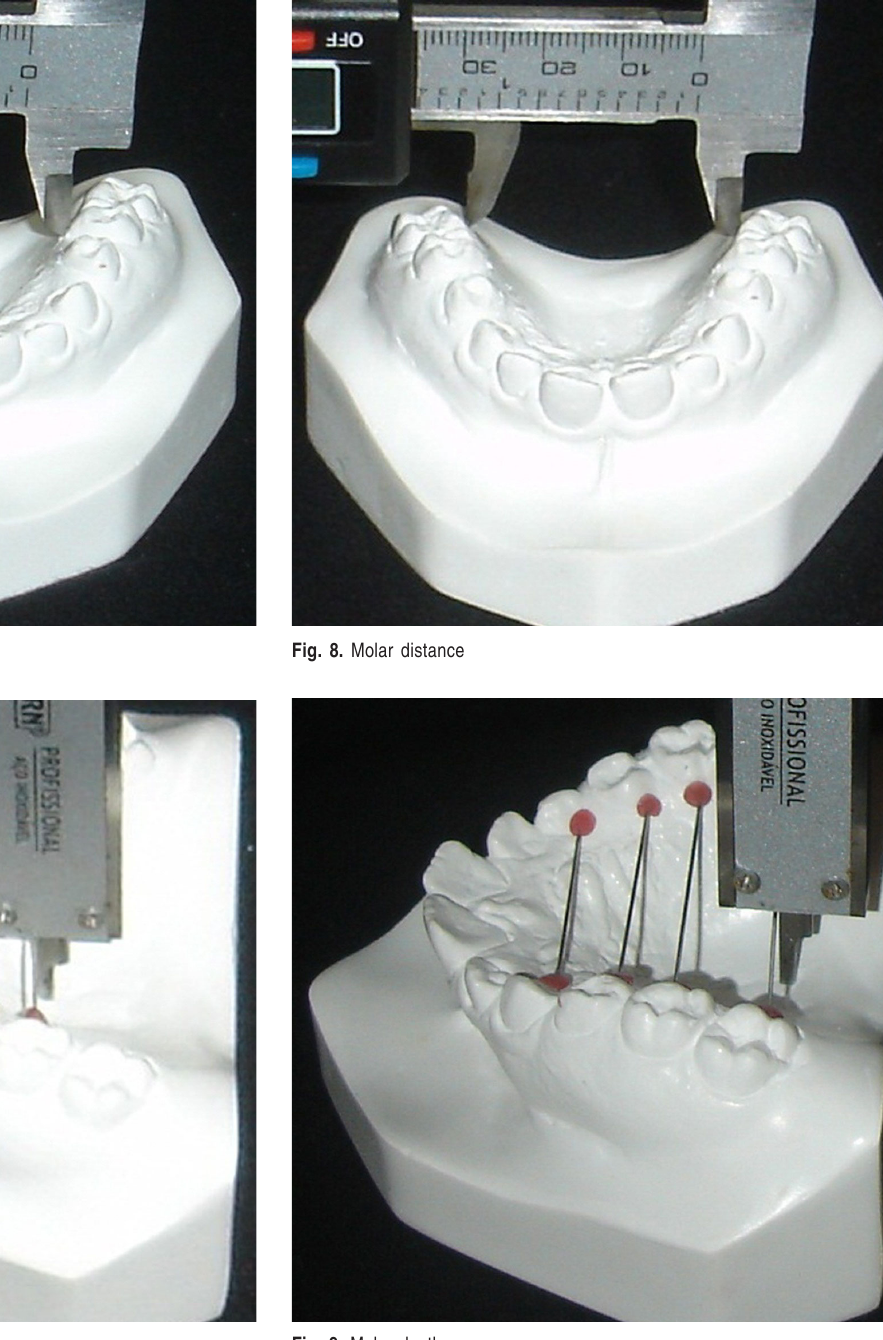
h) Molar depth: vertical measurement in millimeters from